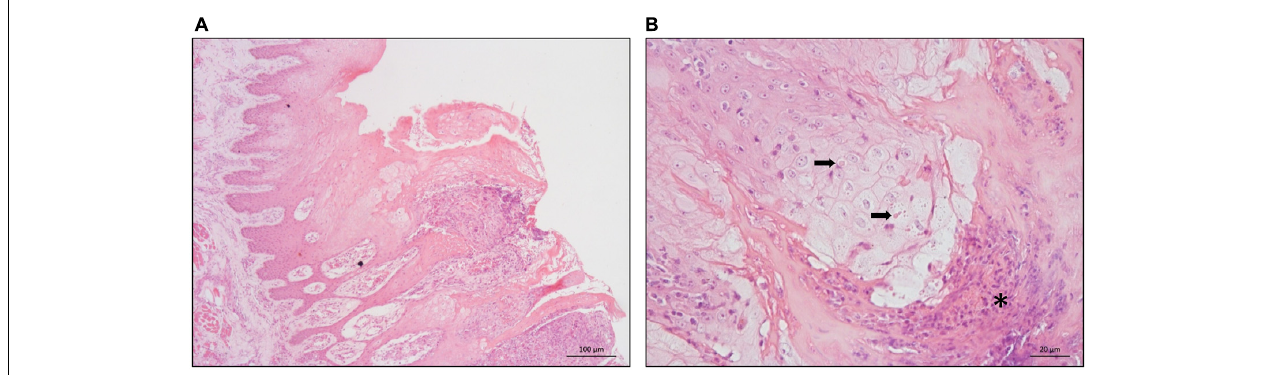
FIGURE 3 | Histopathology of buffalo tongue lesions. (A) Hyperplasia of the epithelium associated with hydropic degeneration of the keratinocytes and pustular formations – 100 µ m scale bar. (B) Hydropic degeneration of the epithelium associated with eosinophilic inclusions in the cytoplasm of keratinocytes (arrows) and pustular formations (asterisks) – 20 µ m scale bar.